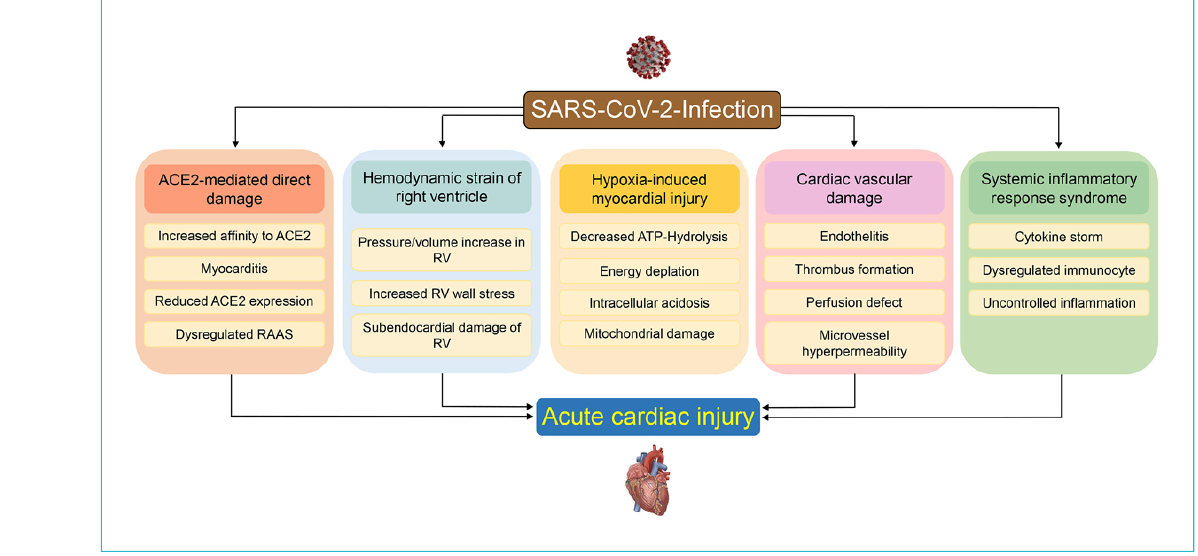
Figure 2: Potential mechanisms of SARS-CoV-2-mediated myocardial injury. Myocardial injury might occur secondary to the infection of the myocardium or secondary to mechanisms related to the pulmonary and systemic infection. These mechanisms include hypoxia induced decrease of oxygen supply to the heart, right ventricular pressure and volume overload, infectious damage of the macro-and microvasculature, and cytokine-induced injury. See text for